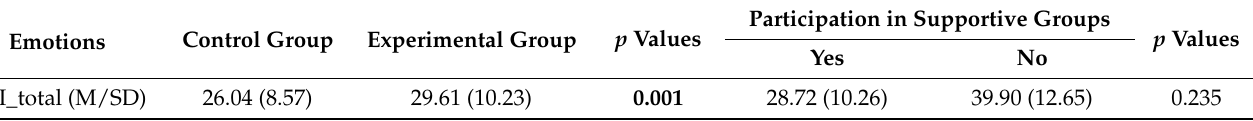
Table 6. Emotional function during the pandemic— Stress Symptoms .